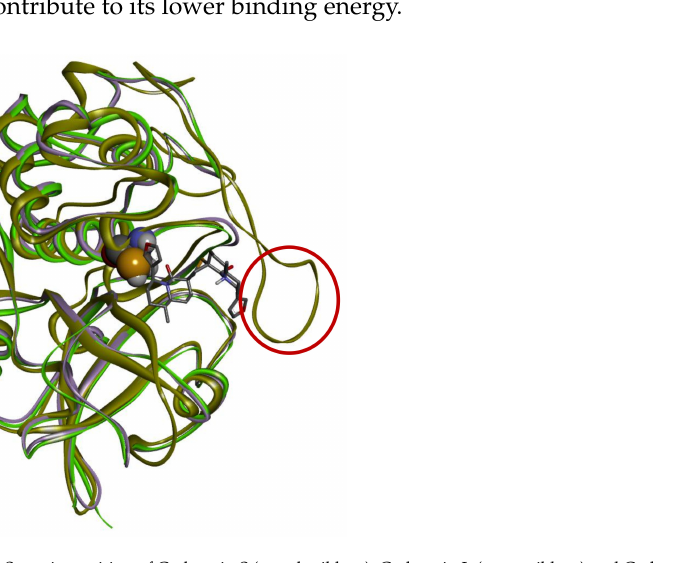
Figure 2. Superimposition of Cathepsin S (purple ribbon), Cathepsin L (green ribbon) and Cathepsin B (gold ribbon). Cathep- sin B loop is indicated by a red circle. Docking of DTBN (grey lines) to Cathepsin